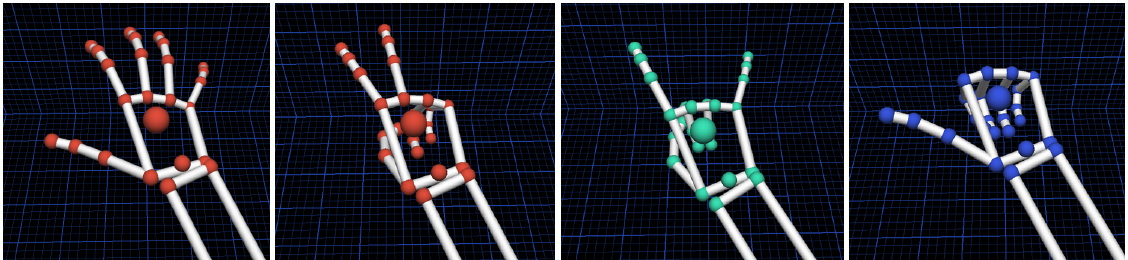
Figure 3. Some samples of hand poses, as provided by the Leap Motion